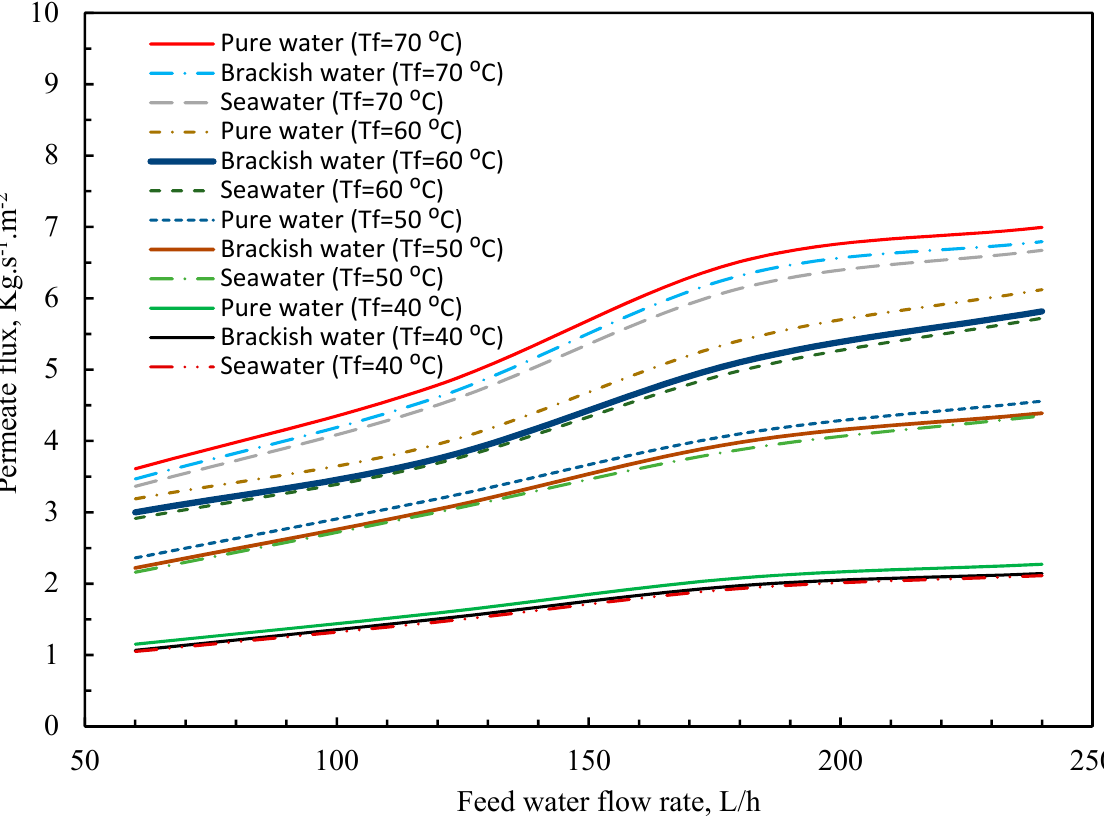
Figure 7. Pure, brackish, and seawater water flux versus feed temperature and water flow rate.